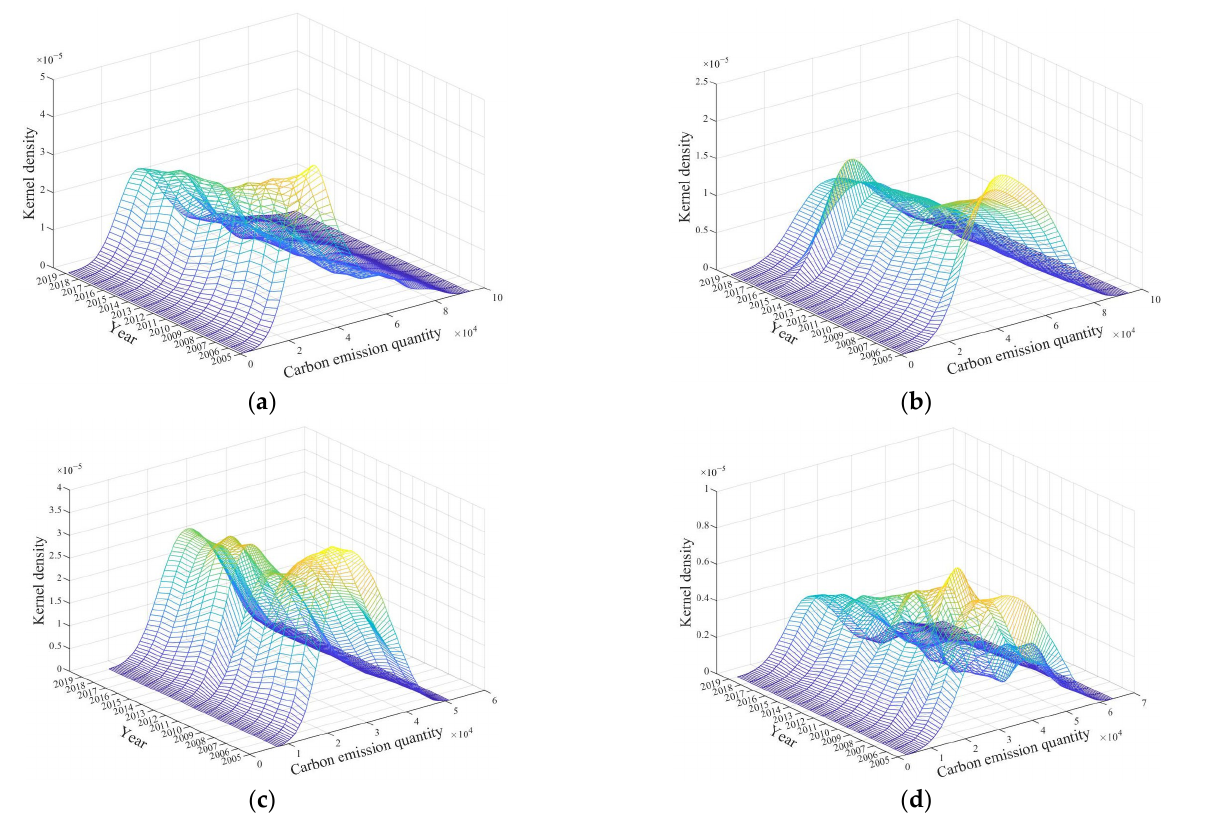
Figure 5. Kernel density estimation of national and regional carbon emission quantity from 2005 to 2019. ( a ) National. ( b ) Eastern region. ( c ) Central region. ( d ) Western region.